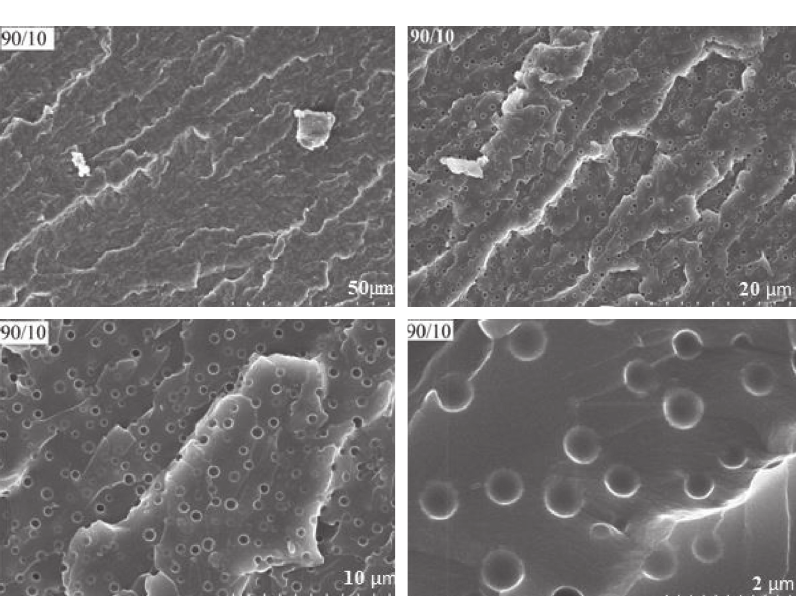
Figure 1: FE-SEM of the sample epoxy Epikote 240/epoxidised linseed oil images with ratio 90/10phr (with other resolutions).